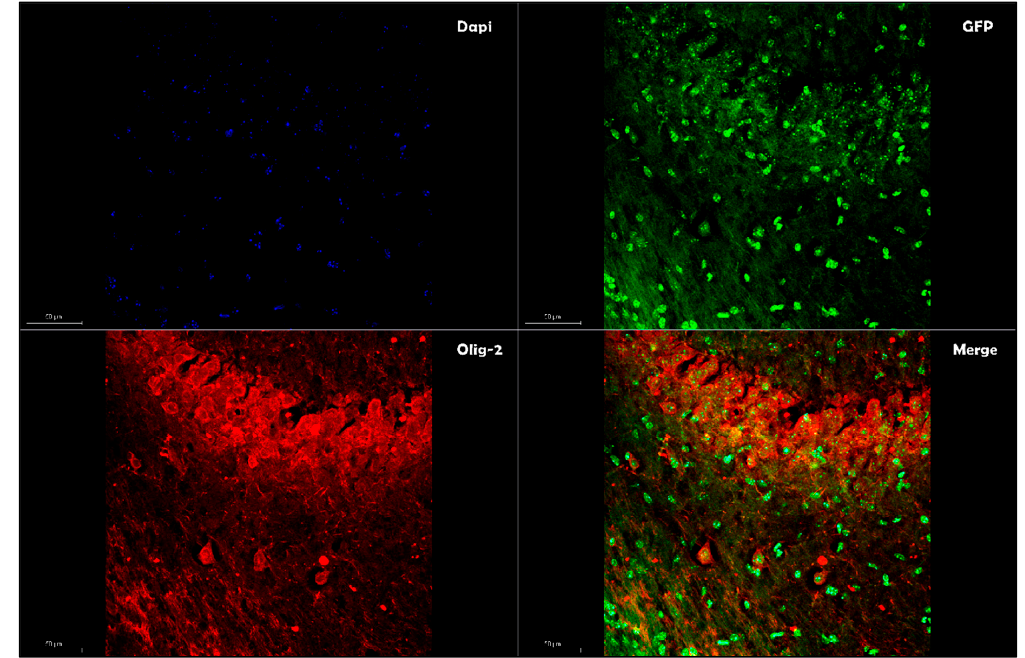
Figure 2. Exosome-enveloped AAVs enhance transgene expressions in oligodendrocytes. The colocalization of GFP (green) with oligodendrocytes marker Olig-2 (Merge) expressed by exosome-enveloped AAV vectors. Images were taken using a Leica SP8 confocal microscope at 20× magnification. Scale bar represents 50 µm.